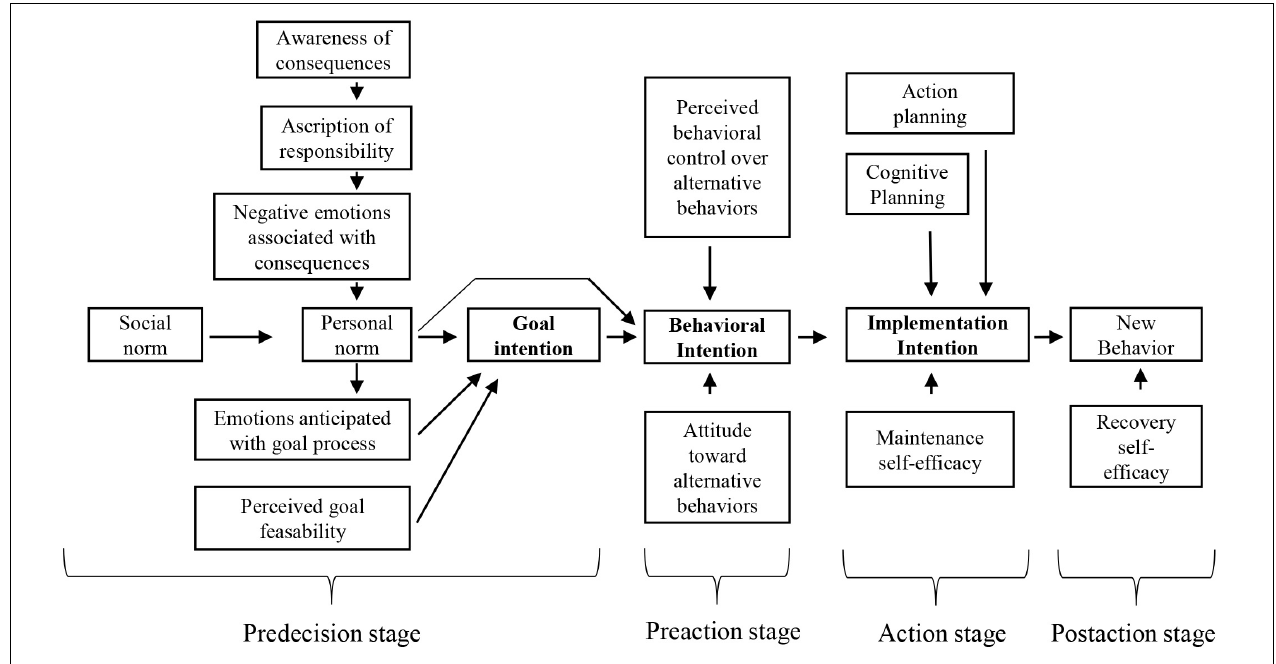
FIGURE 1 | The stage model of self-regulated behavioral change, adapted from Bamberg